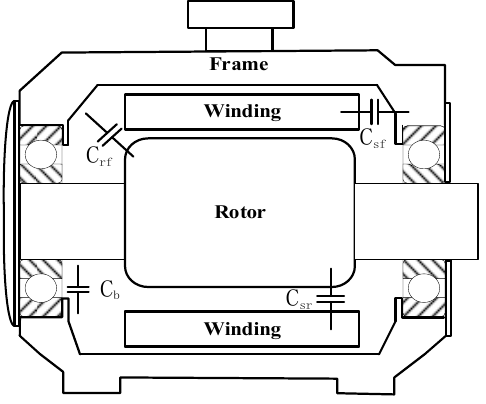
Figure 11. Capacitance coupling in an induction